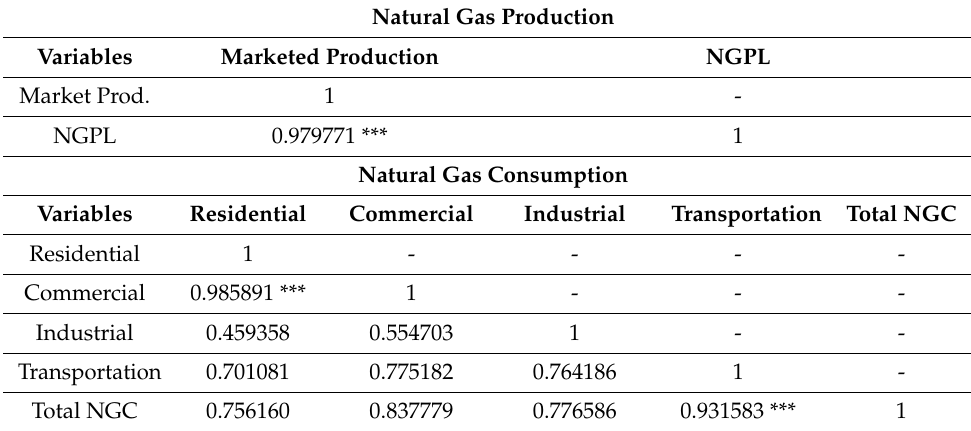
Table 3. Correlation matrix results.